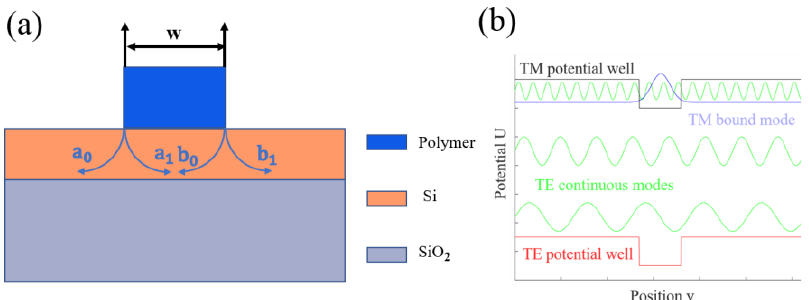
Figure 2. Theoretical analysis of the BIC hybrid waveguide structure. ( a ) The cross-section of the hybrid waveguide structure can support the BIC mode, which contains the radiation channels of the TM bound mode to the TE continuum; ( b ) photonic potential distribution of the hybrid waveguide structures.